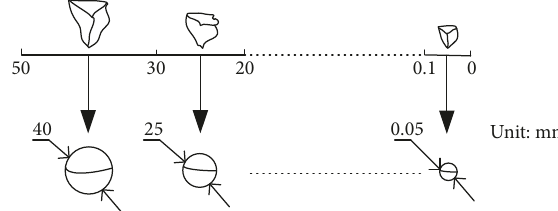
Figure 12: Schematic of converting fragments into spheres.